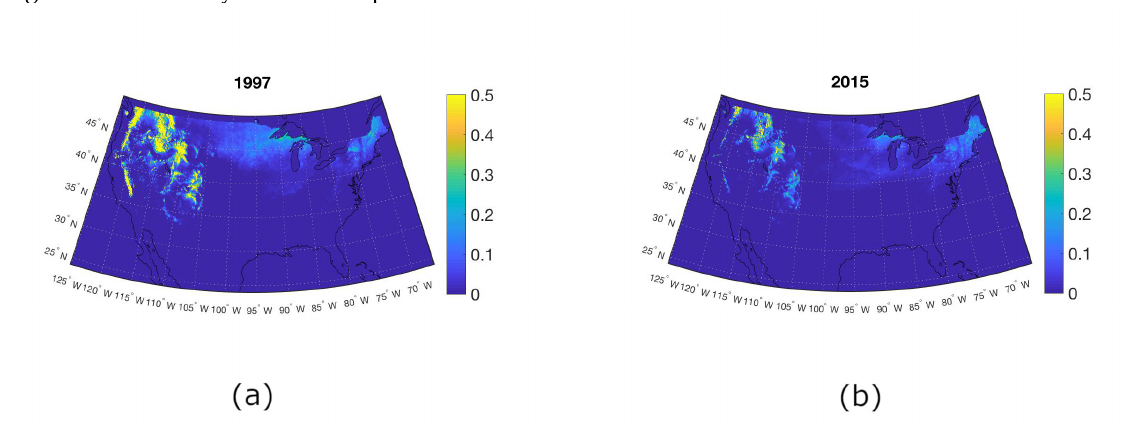
Figure 1. Snow water equivalent (SWE) on 1 February of ( a ) 1997, ( b )